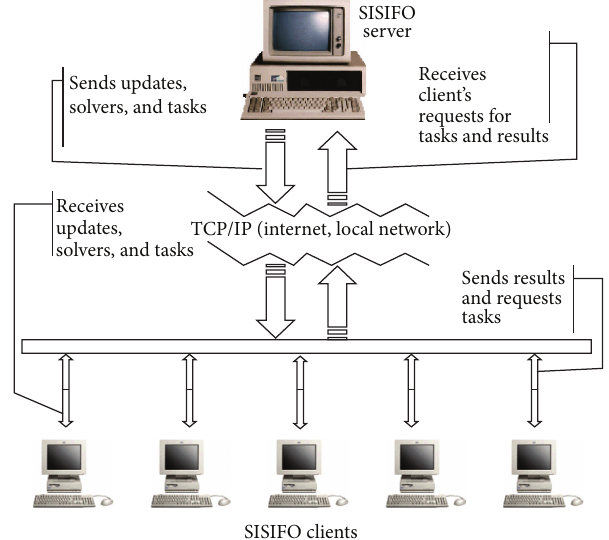
Figure 1: Operation scheme of Sisifo.